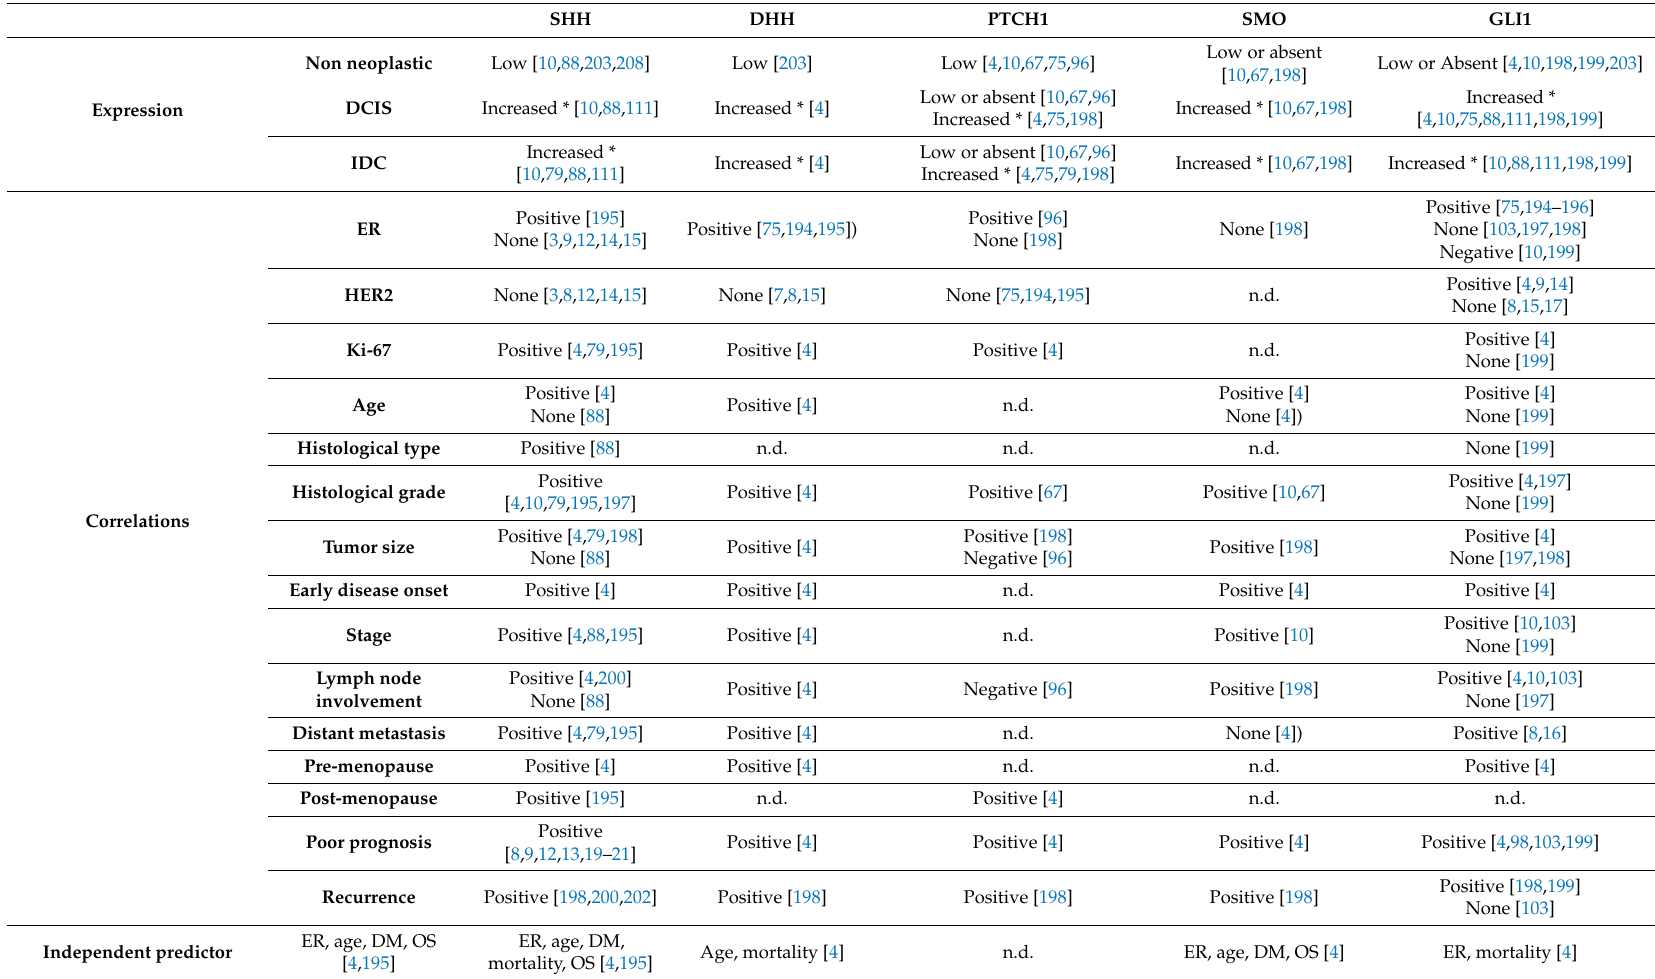
Table 2. Correlation of members of the Hh pathway with clinical and histo-patological parameters of BC patients. . SHH DHH PTCH1 SMO